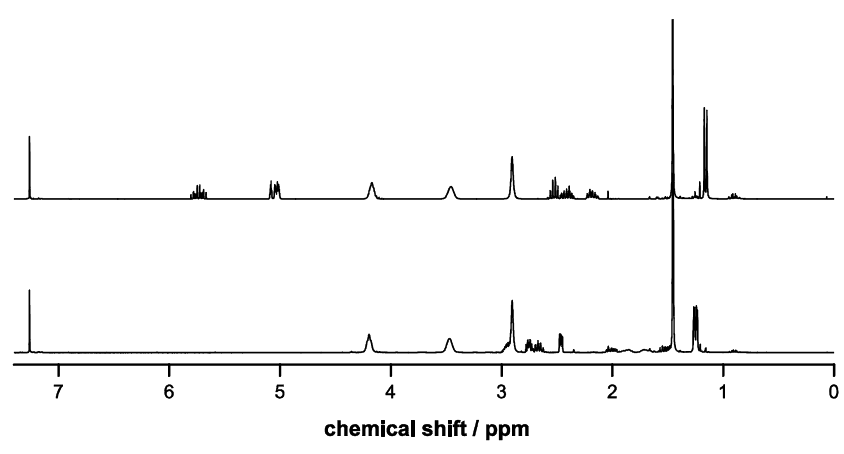
Figure 2. 1 H-NMR spectra of BocN-MP (top) and BocN-MPO